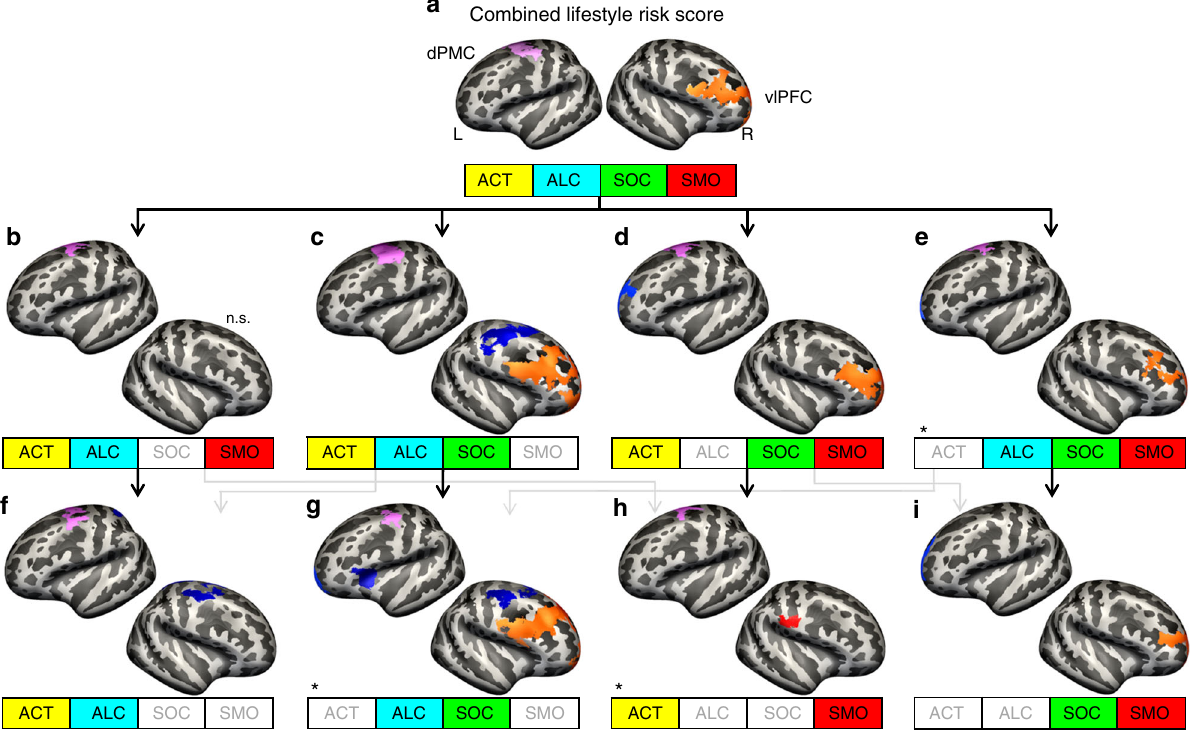
Fig. 2 Differences in cortical folding associated with lifestyle risk in different risk score models. a – i Small boxes represent different risk score models derived from the stepwise exclusion approach with excluded single lifestyle variables grayed out. Associations between cortical folding and the combined lifestyle risk score, or the different risk score models, respectively, are depicted on the in fl ated surfaces of the fsaverage brain. Arrows indicate the work fl ow of the stepwise exclusion. Negative associations are represented in blue, and positive associations in red. The recurrent negative associations between higher lifestyle risk and reduced cortical folding in left dorsal premotor cortex (dPMC) and right ventro-lateral prefrontal cortex (vlPFC) are colored in pink and orange, respectively. All results are corrected for age and gender and corrected for multiple comparisons using Monte Carlo Z simulations with α = 0.05. Some of the associated regions in speci fi c risk score models marked with an asterisk did not pass an additional correction for multiple comparisons at α = 0.05/13 = 0.0033. For detailed information see Supplementary Table 2. n.s. = not signi fi cant, ACT = physical activity, ALC = alcohol consumption, SOC = social integration, SMO = pack years of smoking, L = left hemisphere, R = right